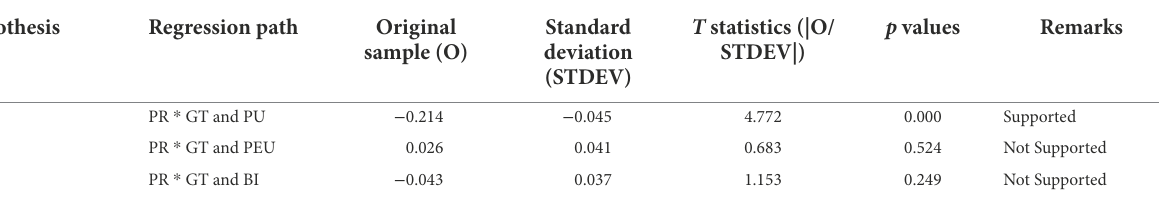
TABLE 7 Moderating effect of perceived